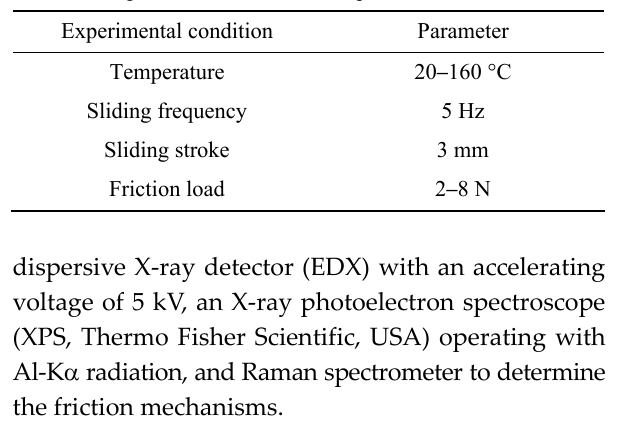
Table 2 Experimental conditions and parameters for friction tests.